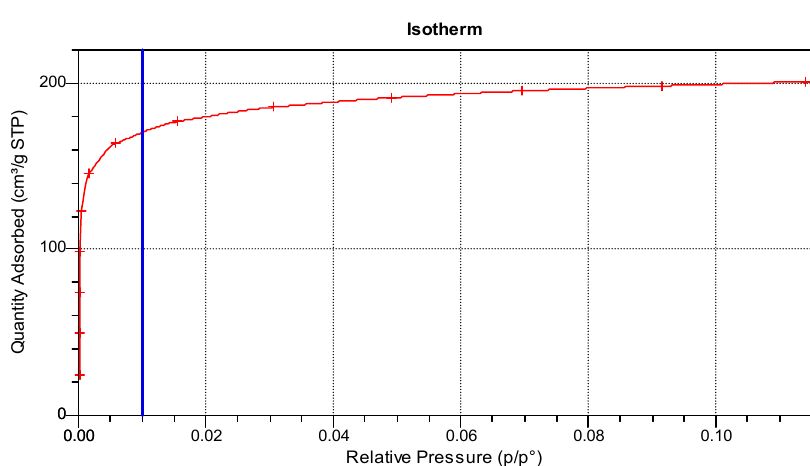
0.000.00 Relative Pressure (p/p°) Figure A2. BET isotherm POR-P40. Figure A2. BET isotherm